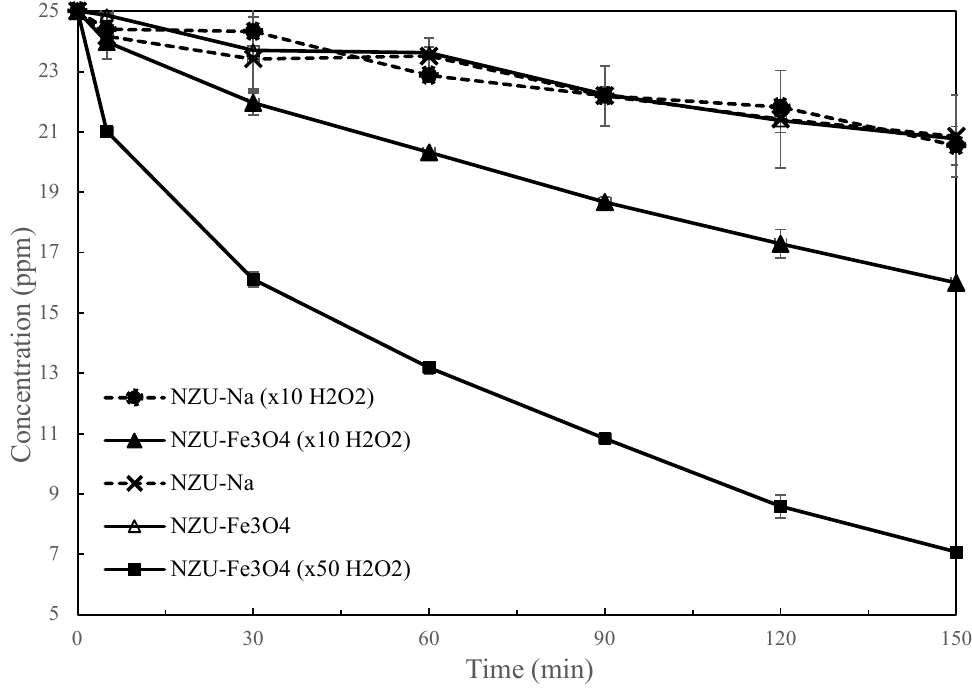
Table 3. Models results. Figure 11. Kinetics of MB solutions discoloration by the modified zeolites. Figure 11. Kinetics of MB solutions discoloration by the modified zeolites.